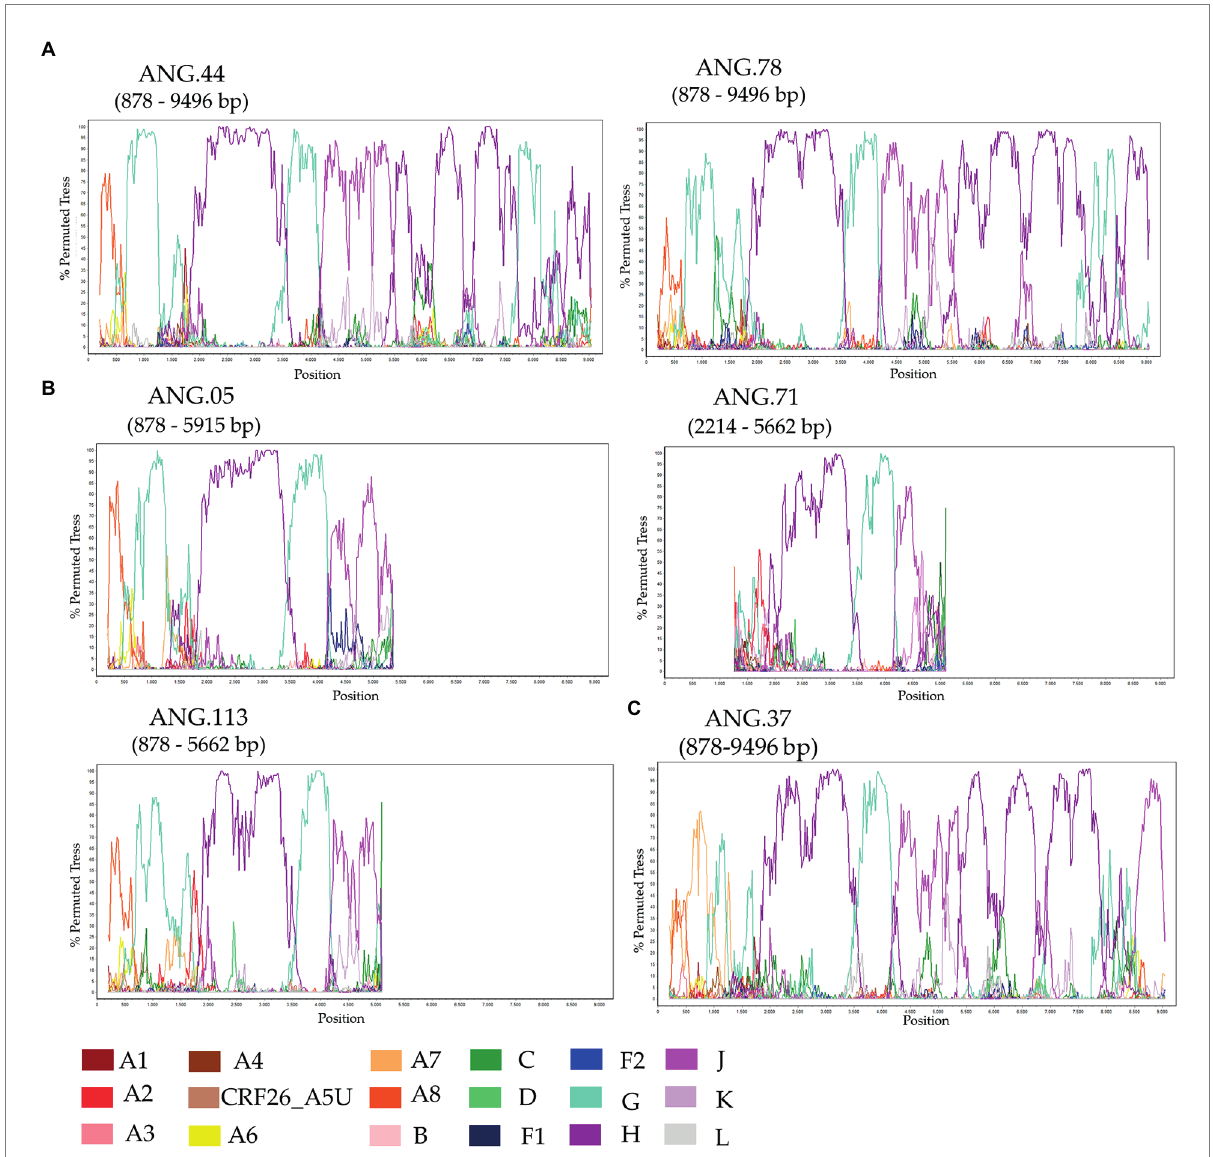
FIGURE 1 Investigation of human immunodeficiency virus (HIV) genome recombination in HIV-1 samples from Angola. Bootscan analysis was performed in SimPlot software using a 400 nt sliding window and 20 nt increments. (A) Complete genome (ANG.44 and ANG.78), (B) Partial genome (ANG.05, ANG.71, and ANG.113), and (C) ANG.37. The legend in the lower corner indicates the colors that represent the different clades of